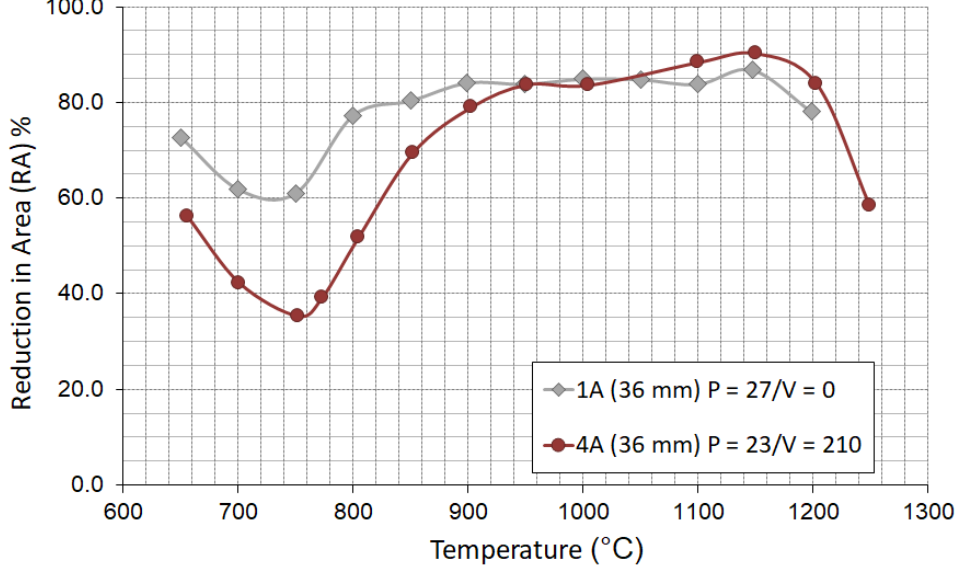
Figure 6. Hot ductility for V-free steel (1A) and a 0.2 wt.% V containing steel (4A) in the solution- treated condition.